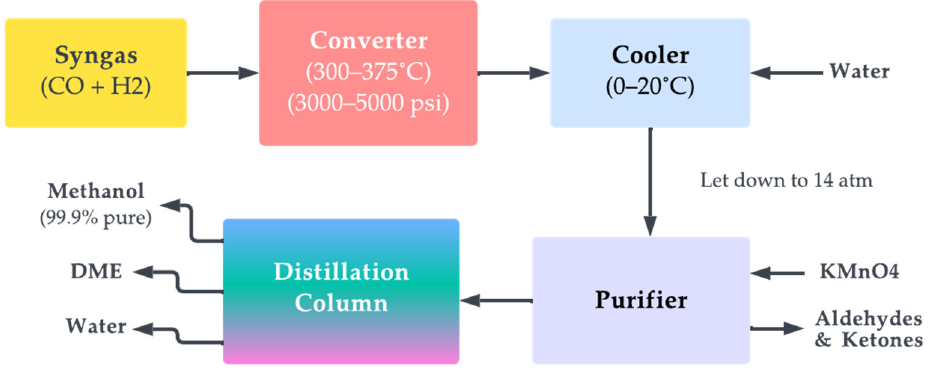
Figure 11. Methanol synthesis process.